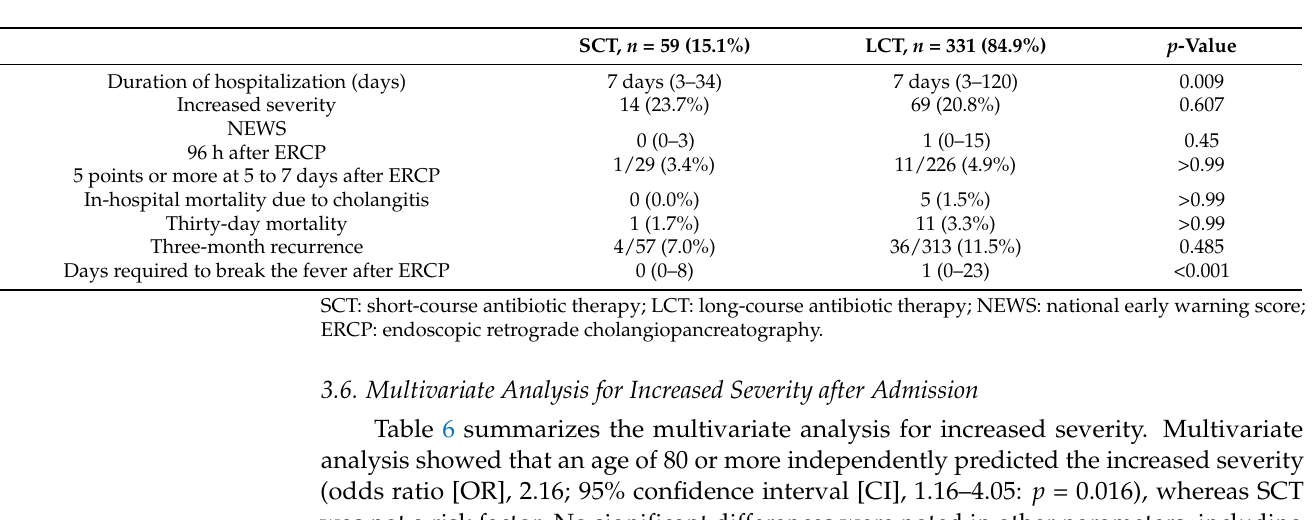
Table 5. Clinical outcomes.